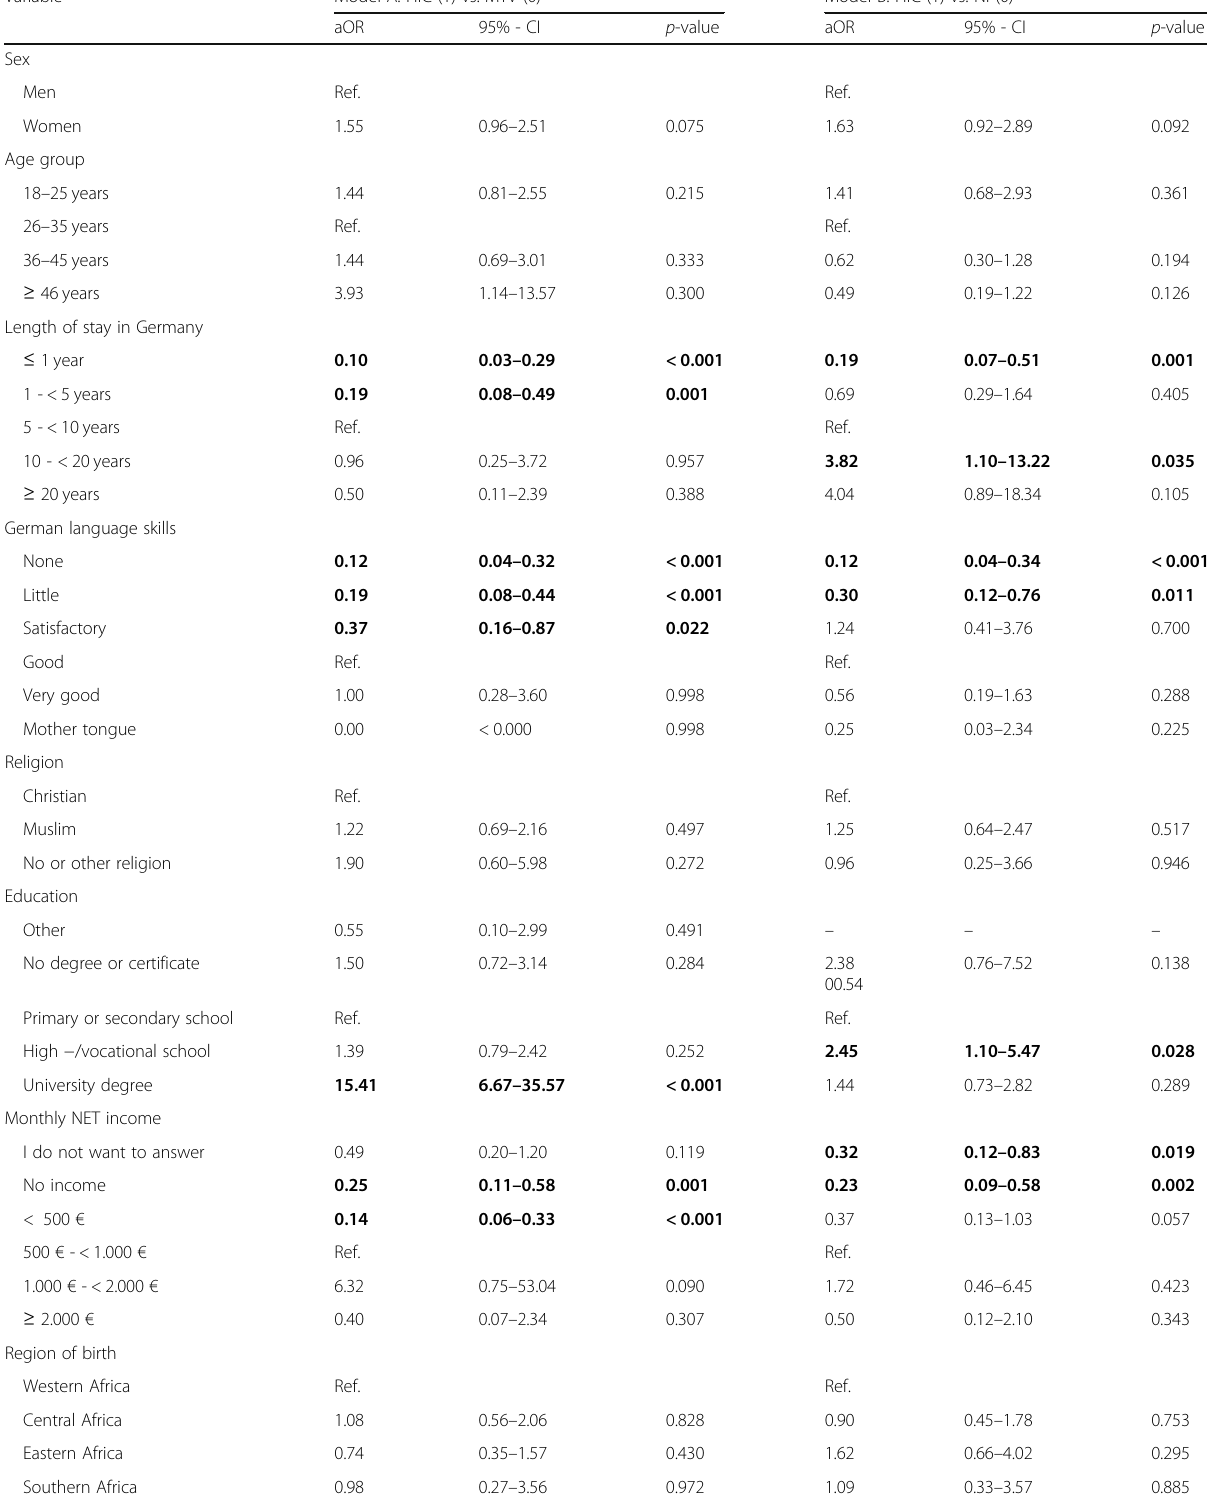
Table 4 Multivariate analysis on health insurance status (including factors significantly associated with health insurance status in univariate